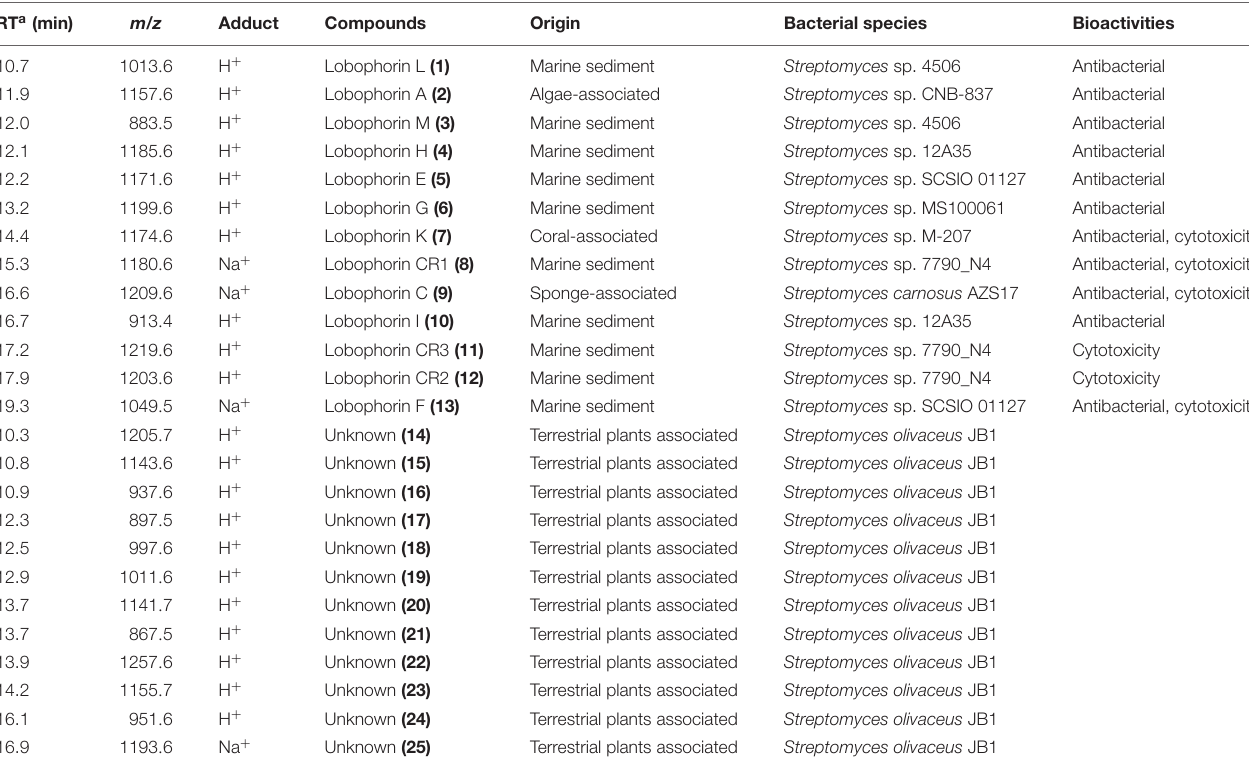
TABLE 1 | List of previously isolated lobophorins that detected from S. olivaceus JB1 and unknown compounds of S. olivaceus JB1. RT a (min) m / z